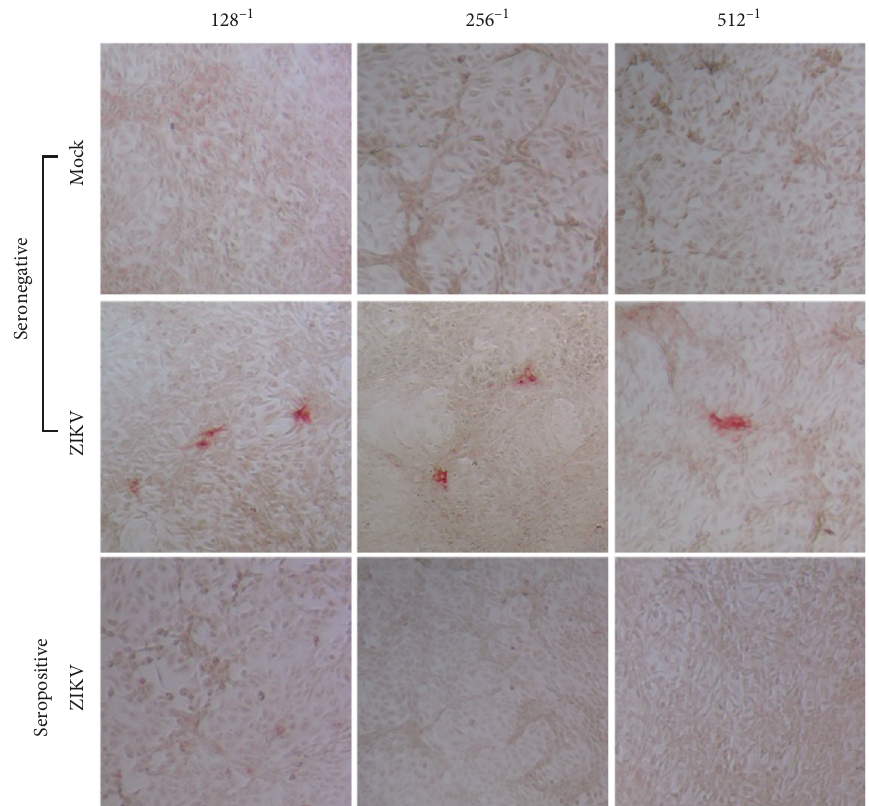
Figure 5: FFAs of plasma from patients after contacting ZIKV-PR in vitro. Conventional light microscopy photographs at 10X. Mock or ZIKV was added in known amounts to plasma specimens from ZIKV-IgG-seronegative or ZIKV-IgG-seropositive patients and incubated for 1 h at room temperature. The FFAs were performed under optimal conditions. The foci detected at the respective dilutions of the plasma incubated with ZIKV-PRVA BC59 are shown. Seronegative (patient code SU 673) and seropositive (patient code ZM 163). A representative experiment of three replicates is Table 2: Spike recovery assay results for ZIKV in FFA.